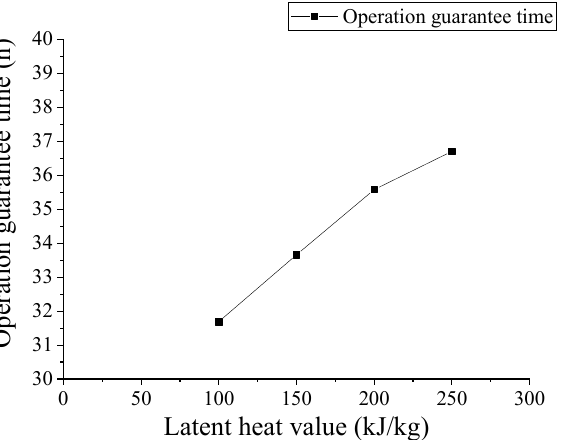
Figure 11. Effect of latent heat on the melting rate of the heat storage module. By analyzing the outlet temperature of the reservoir at the third stage, with the increase in the latent heat value of the phase change, the time required for the outlet temperature to reach the set limit temperature t lim gradually increases. The main reason is that, as the latent heat value of the phase change increases, the heat storage capacity of the reservoir is enhanced. In that case, it can guarantee the improvement in the operation time of the air-conditioning unit. Therefore, the higher the latent heat value of the phase change is, the more favorable it is to the system energy storage. PCM with high latent heat should be selected as far as possible in the heat storage system of the reservoir. Figure 12 shows the guaranteed reservoir operation time under different latent heat values of phase change which increases with the increase in the latent heat value. Further analysis shows that, under simulated conditions, the slope increases more when the latent heat value increases from 100 kJ/kg to 200 kJ/kg than when the latent heat value increases from 200 kJ/kg to 250 kJ/kg. That is, with the further increase in the latent heat value, its influence on the guaranteed operation time of the reservoir decreases. In consideration of the reparability and economy of PCM with a high latent heat value, the availability and price of PCM should also be considered in practical engineering design. In a practical application, the PCM with a latent heat value of 200 kJ/kg has more types and a wider selection range than PCM with a latent heat value of 250 kJ/kg.